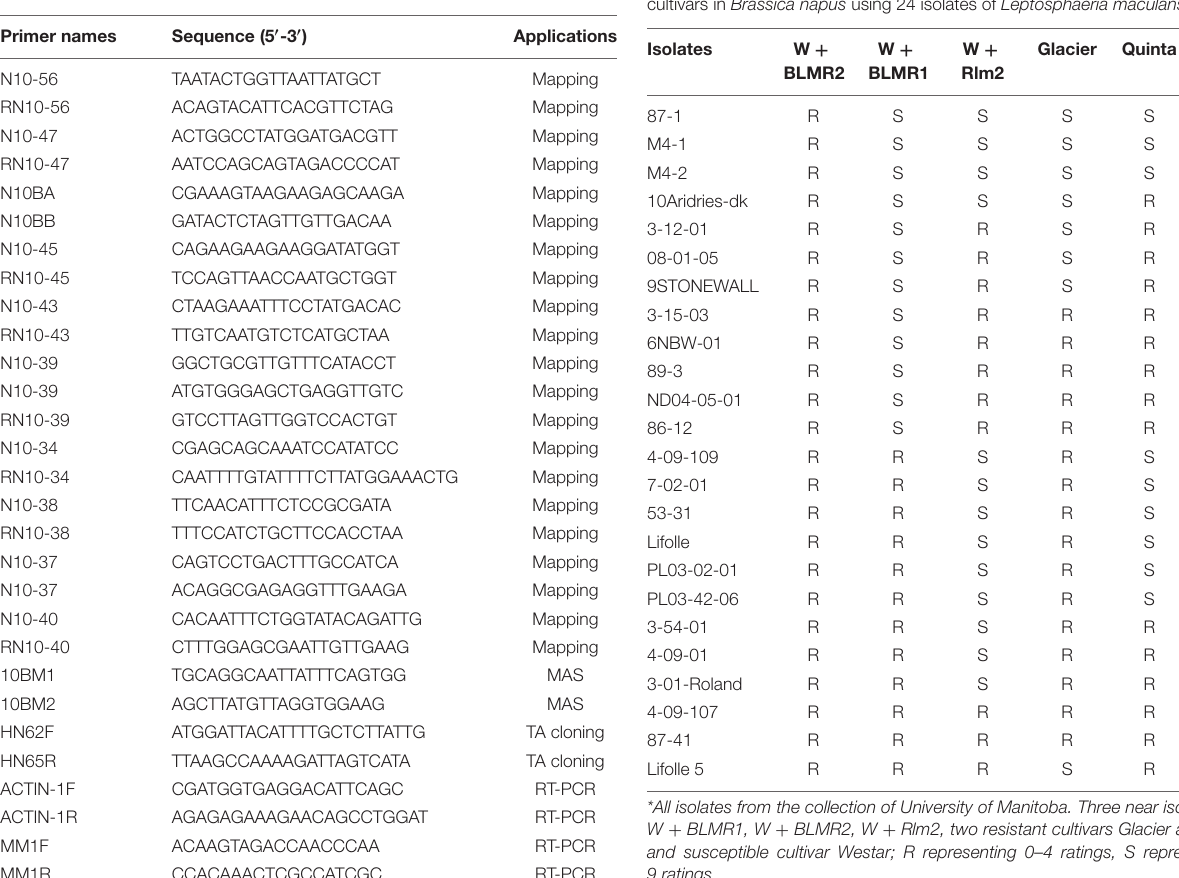
TABLE 1 | Primers for all applications.